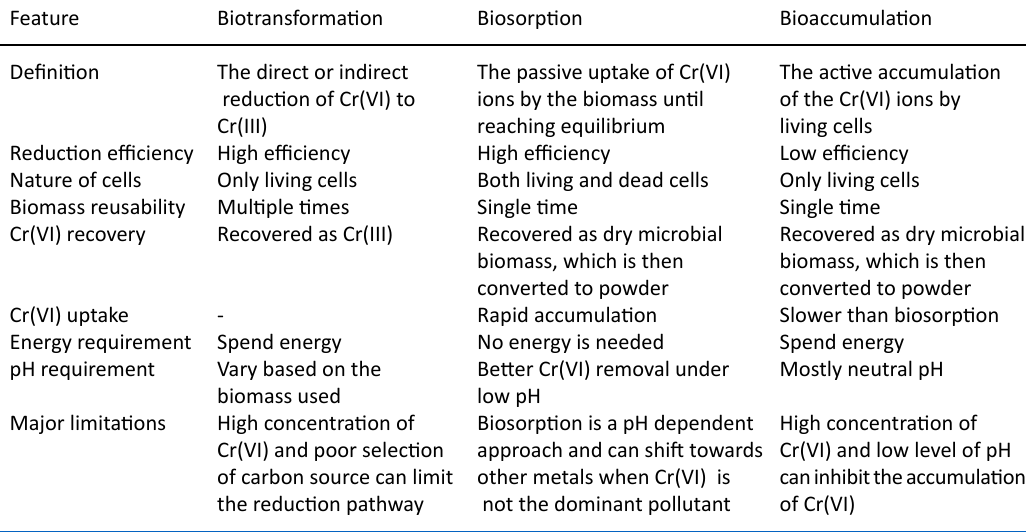
table 2. Comparison of the three Cr(VI) removal